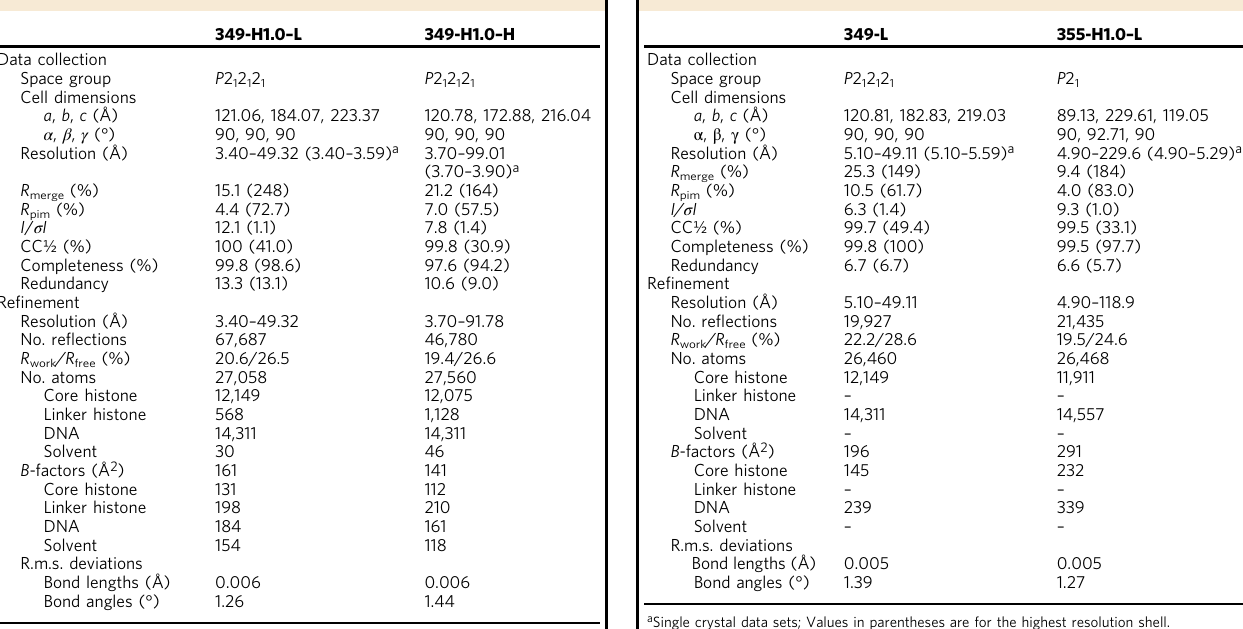
Table 1 Data collection and re fi nement statistics for 349 dinucleosome assembled with linker histone (H1.0) and crystals stabilized in either a low (L) or high concentration (H) of cryoprotectant.